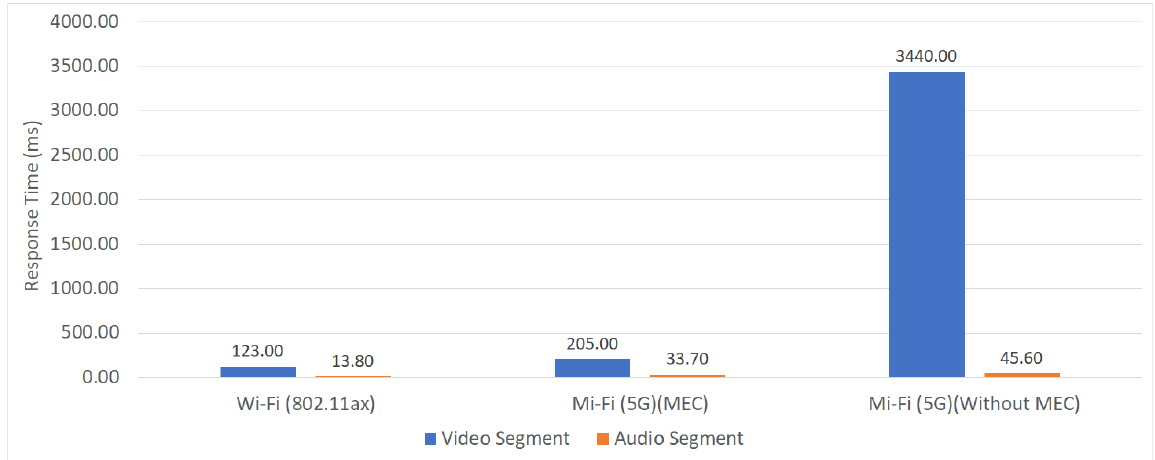
Figure 11. Response Time in Streaming Test Result.